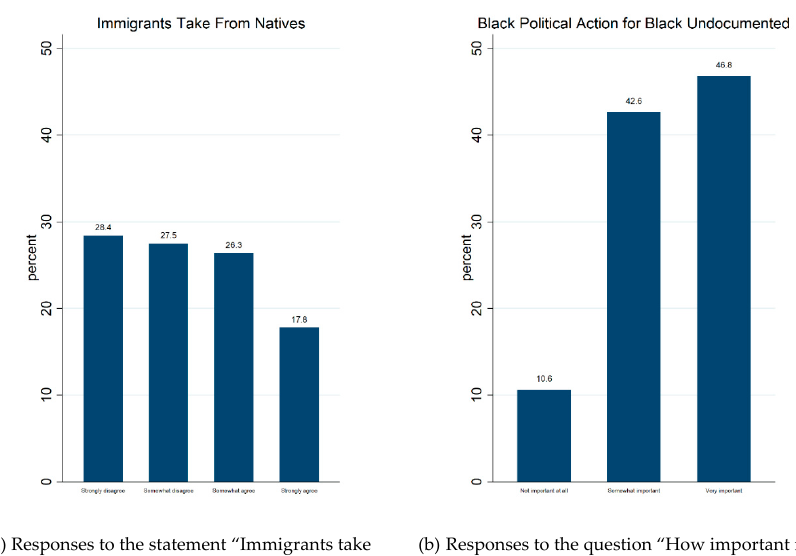
Figure 2. Black Support for Implicit Anti-Immigrant Policy.